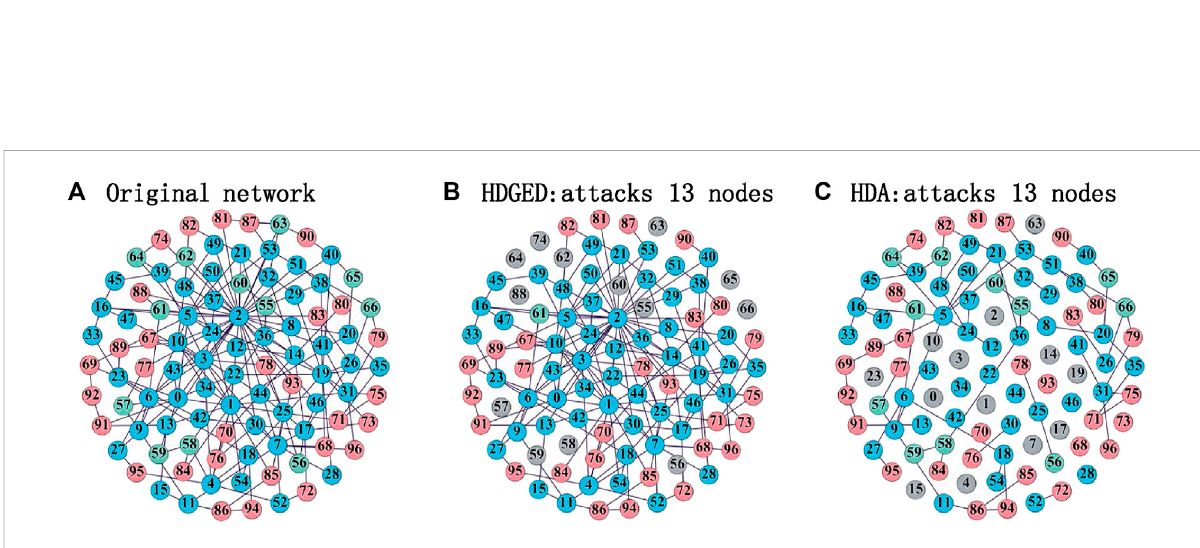
FIGURE 15 ComparisonofdisintegrationcapabilityofHDGEDandHDAonascale-freeHCNofscale97. (A) istheHCNofscale97,inwhichthebluenodeis the sensor entity, the green node is the decision entity, the red node is the in fl uence entity, the numbers of the three of them are 55, 12, and 30, respectively. (B) shows the result after HDGED attacks the 13 nodes in the original network, and the gray node is the attacked entity, P ( ~ V ) = 0. (C) shows the result after HDA attacks the 13 nodes in the original network, P ( ~ V ) = 0.63.